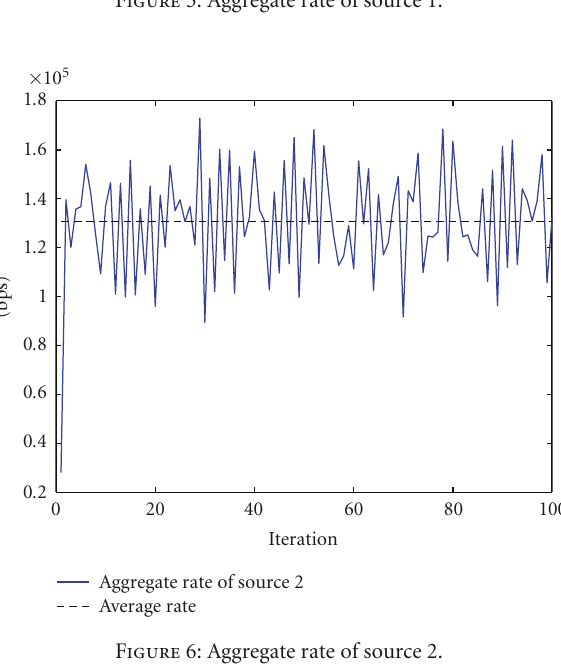
Figure 5: Aggregate rate of source 1.